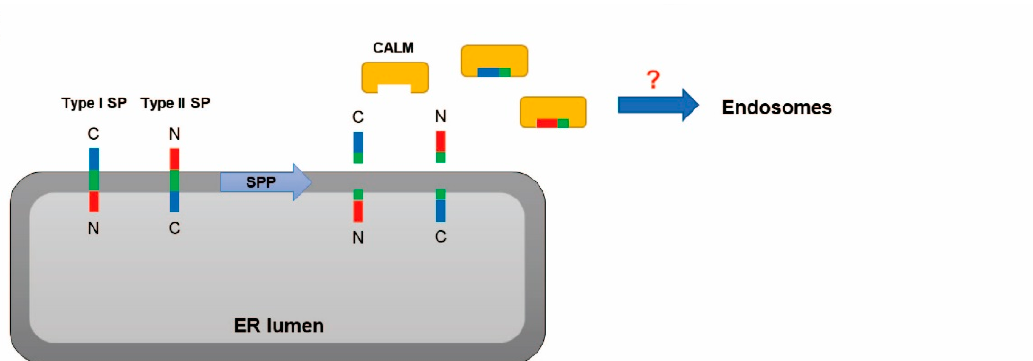
Figure 6. Binding of exosomal SP fragments with CALM in the presence of Ca 2+ . ( A ) The peptide solution extracted from His-tagged CALM was analyzed by MALDI-TOF MS. ( B ) The peak intensity at 861 was measured by MALDI-TOF MS. ND, not detected. *** p < 0.001 vs. CALM(+)/APP SP(+)/Ca 2+ ( − ). ( C ) MS/MS analysis of the peaks at m / z 859 +/ − 4. ( D ) The peak intensity at 861 and 2073 in the presence or absence of CALMIP was measured by MALDI-TOF MS. ND, not detected. *** p < 0.001 vs. CALM(+)/APP SP(+)/Ca 2+ (+)/CALMIP( − ); ( E ) the working hypothesis of this